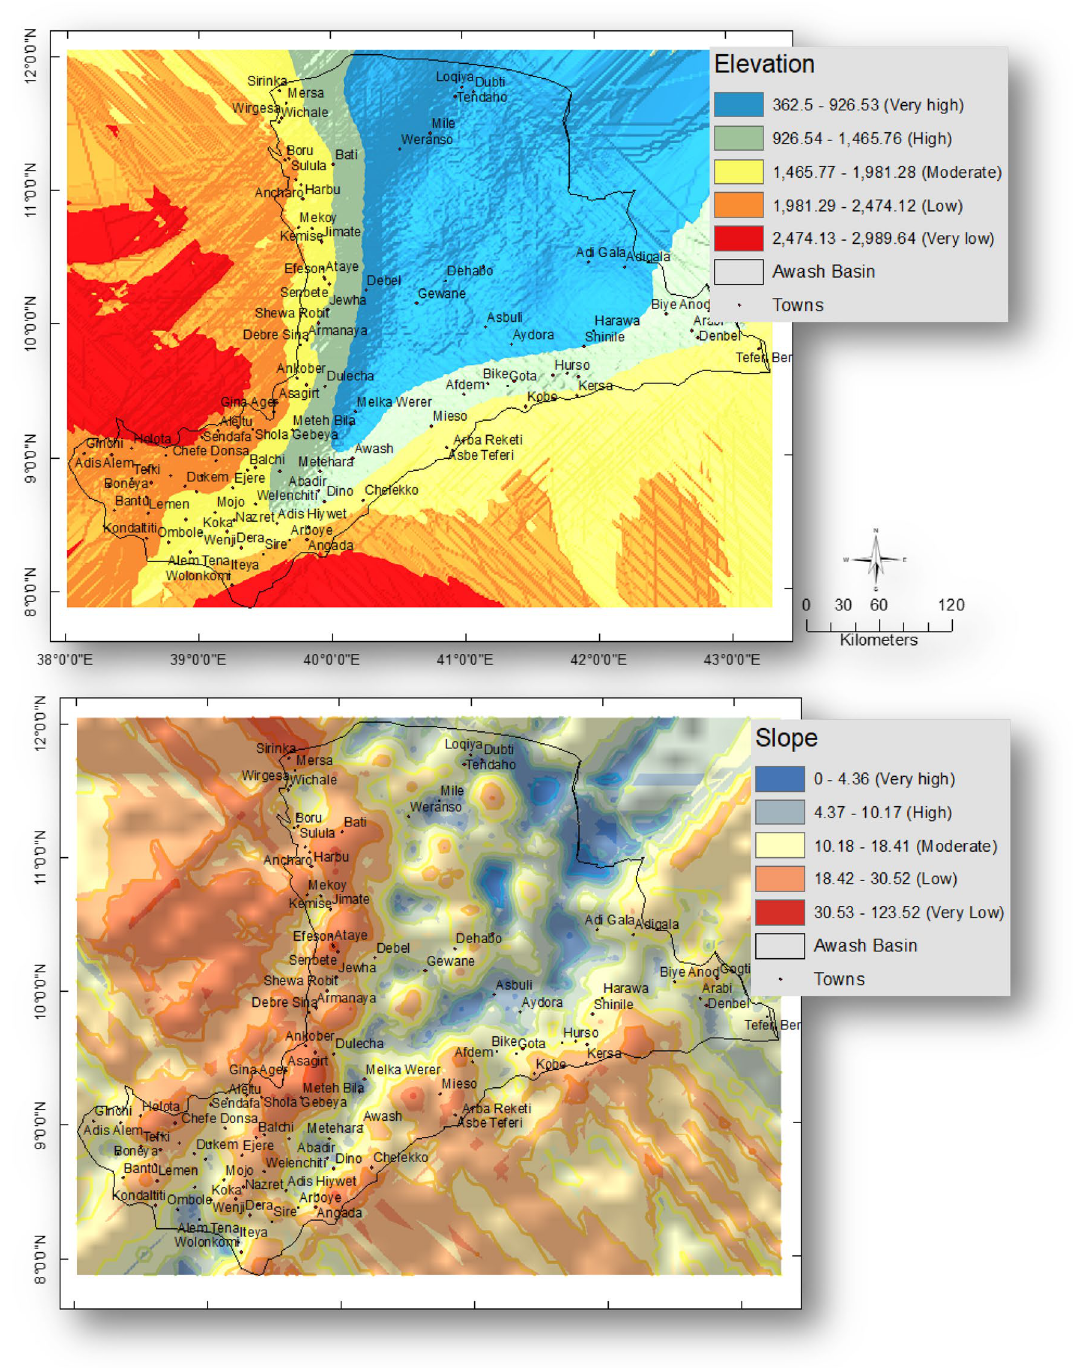
Figure 3. Weighted layers of elevation (meters) and Slope (degrees) of the Awash basin, Ethiopia. This figure was created using ArcGIS 10.3.1